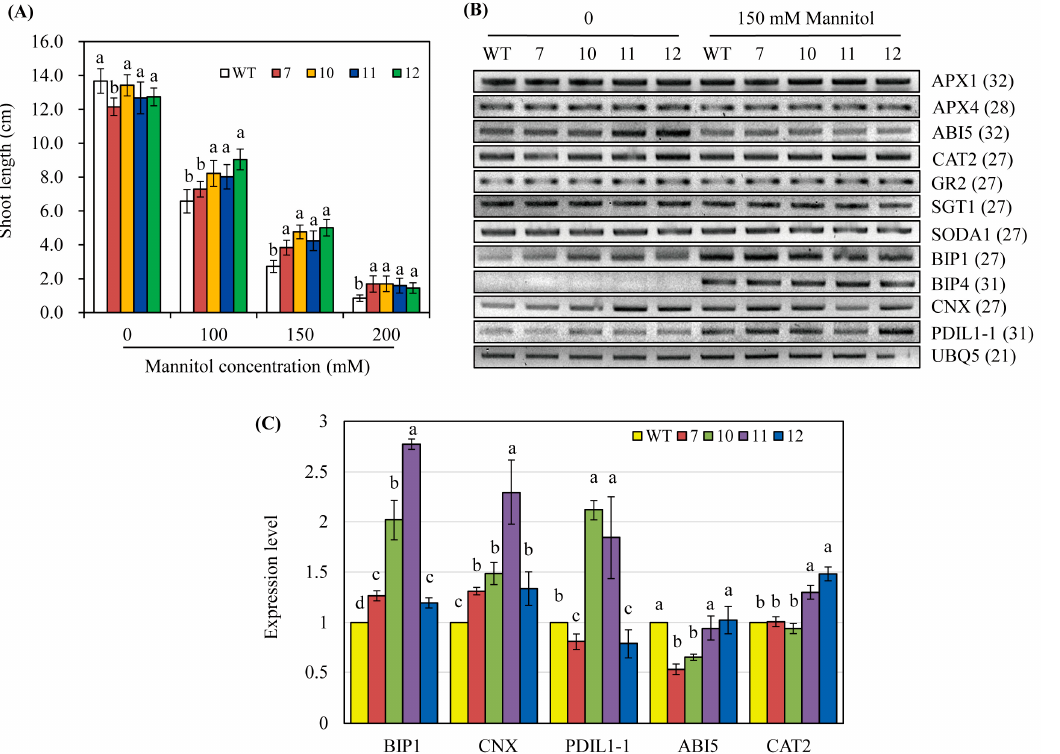
Figure 6. ( A ) Shoot length in the presence of mannitol. ( B ) Expression levels of genes involved in antioxidant and chaperone systems under non-stress and mannitol stress conditions. ( C ) Quantita- tive real-time polymerase chain reaction (qRT-PCR) analyses under non-stress condition. GenBank